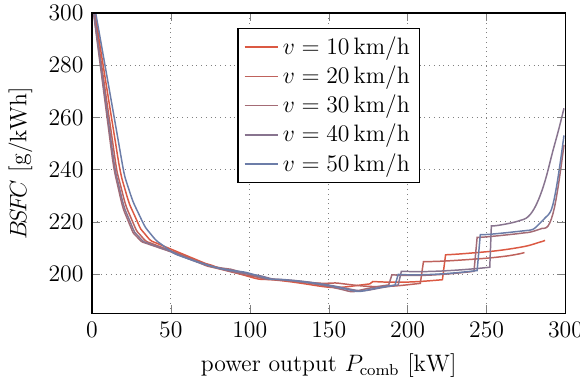
Figure 4. Lowest achievable brake specific fuel consumption using optimal gears (Figure 3) desired power output of the combustion engine.